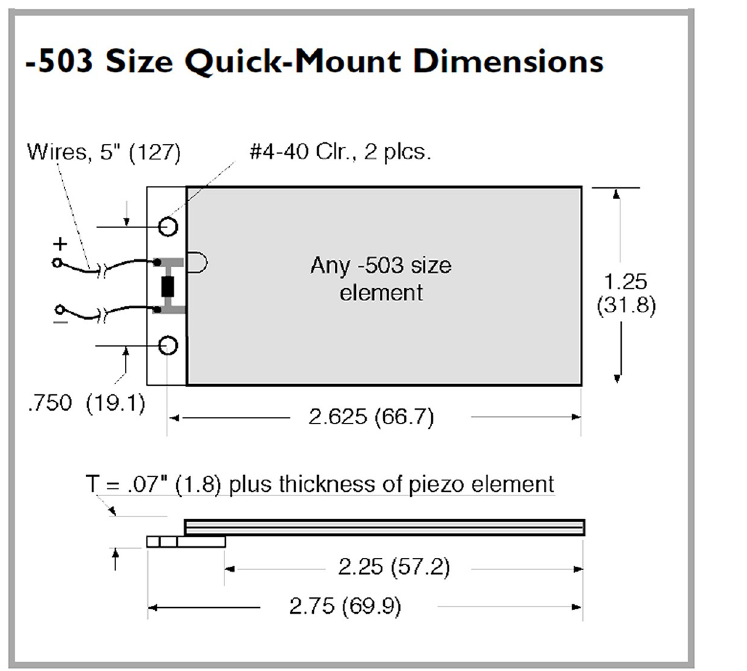
Fig 7. The configuration and the dimensions of piezoelectric transducer QB220-503YB [23].